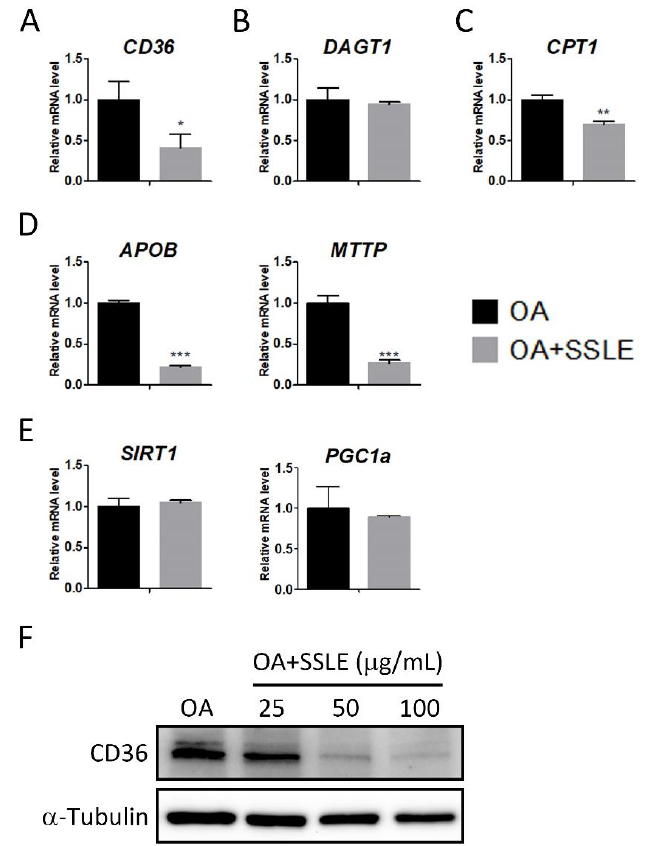
Figure 4. SSLE reduced the mRNA and protein expression of CD36 . ( A – E ) Huh7 cells were treated with 125 µM OA in the presence or absence of 100 µg/mL SSLE for 12 h. RT-qPCR was used to determine the expression profile of lipid metabolism genes. ( A ) Lipid entry: CD36 ; ( B ) TG formation: DGAT1 ; ( C ) β -oxidation: CPT1 ; ( D ) lipid secretion: APOB and MTTP ; ( E ) mitochondria biogenesis: